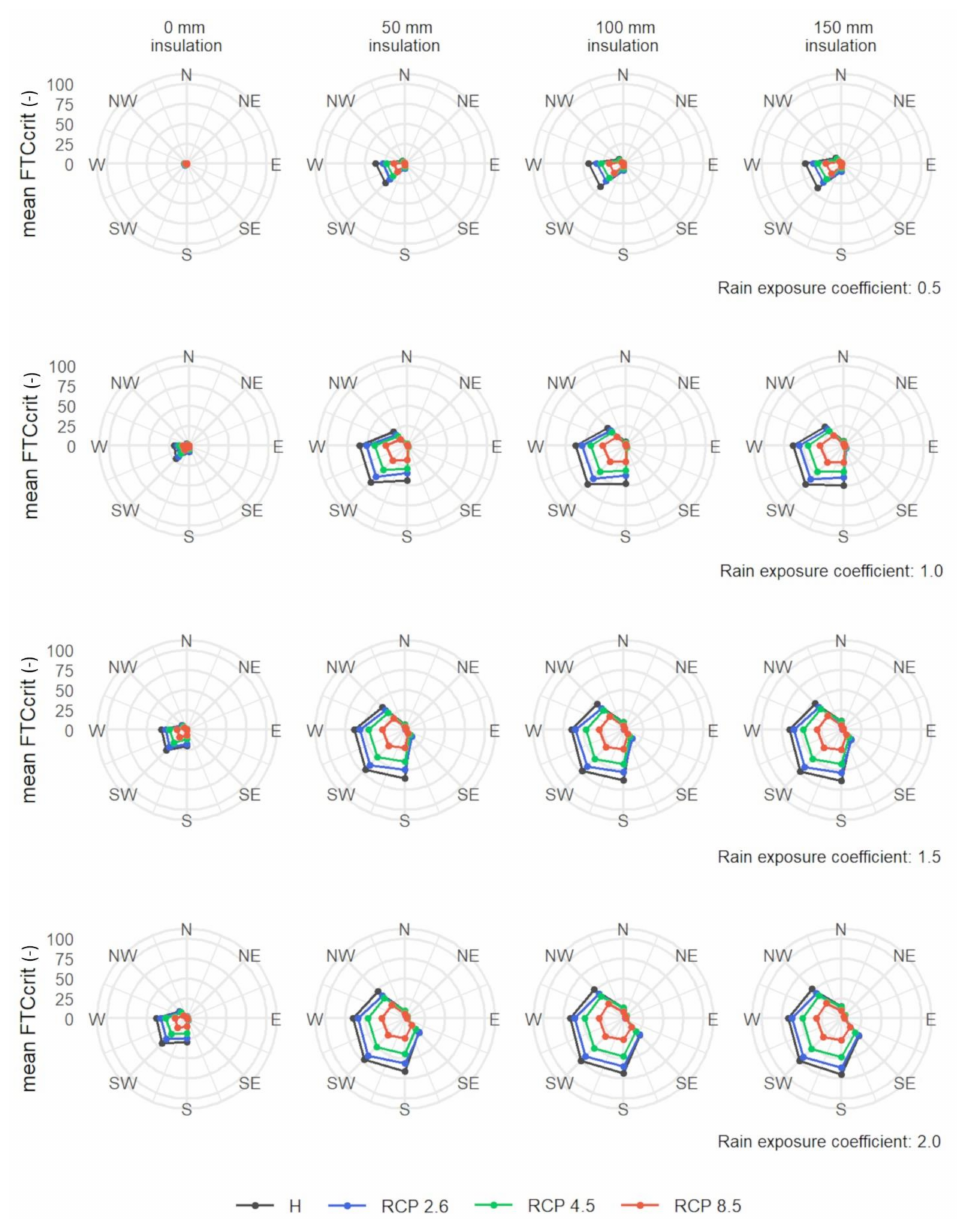
Figure 3. Mean number of critical freeze-thaw cycles (FTC crit ) per orientation for the 300 mm masonry wall of cluster 4 for the historical period (H) and RCP projections. The uninsulated wall and 3 insulated walls with varying thicknesses are presented for each of the rain exposure